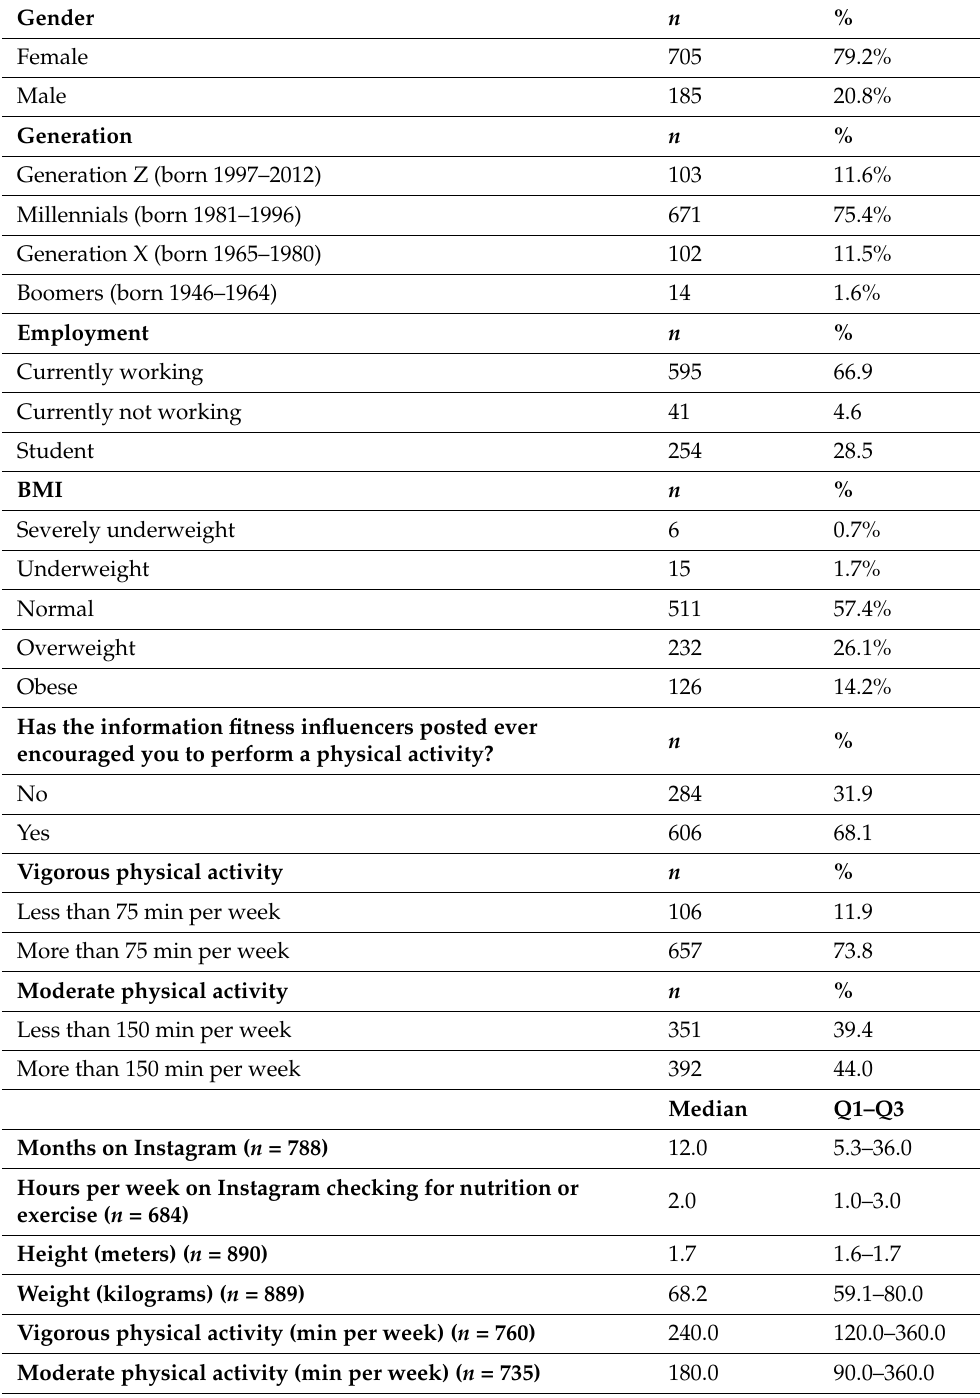
Table 1. Descriptive characteristics of the